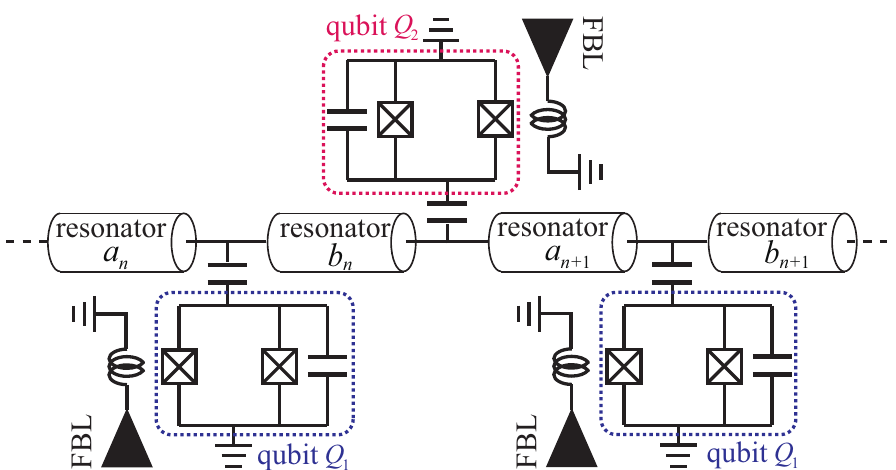
Figure 1. The diagrammatic sketch of the 1D transmission line resonators array. The resonators array is composed by N unit cells (resonators a n and b n are set as one unit cell), in which the two resonators in a unit cell are coupled to each other via a mediated superconducting qubit Q 1 while the two resonators belonging to two adjacent unit cells are coupled to each other via another mediated superconducting qubit Q 2 . The energy level space of each superconducting qubit can be tuned via magnetic flux provided by a flux-bias line (FBL). The size of the resonators array is 2 N . Here H 0 is the free energy of resonators and qubits with resonator frequency ω a ( ω b ) = | e (cid:105) (cid:104) e | − | g (cid:105) (cid:104) g | ( σ z = | e (cid:105) (cid:104) e | − | g (cid:105) (cid:104) g | ). H and Pauli z operator σ z 2, n 2, n 1, n 1, n hop denotes 2, n 1, n = | e (cid:105) (cid:104) g | the coupling between two adjacent resonators via qubit Q 1 ( Q 2 ), in which σ + 1, n 1, n = | e (cid:105) (cid:104) g | ) is the excitation of the superconducting qubit Q | g (cid:105) and | e ( σ + 2, n 1 ( Q 2 ), with 2, n